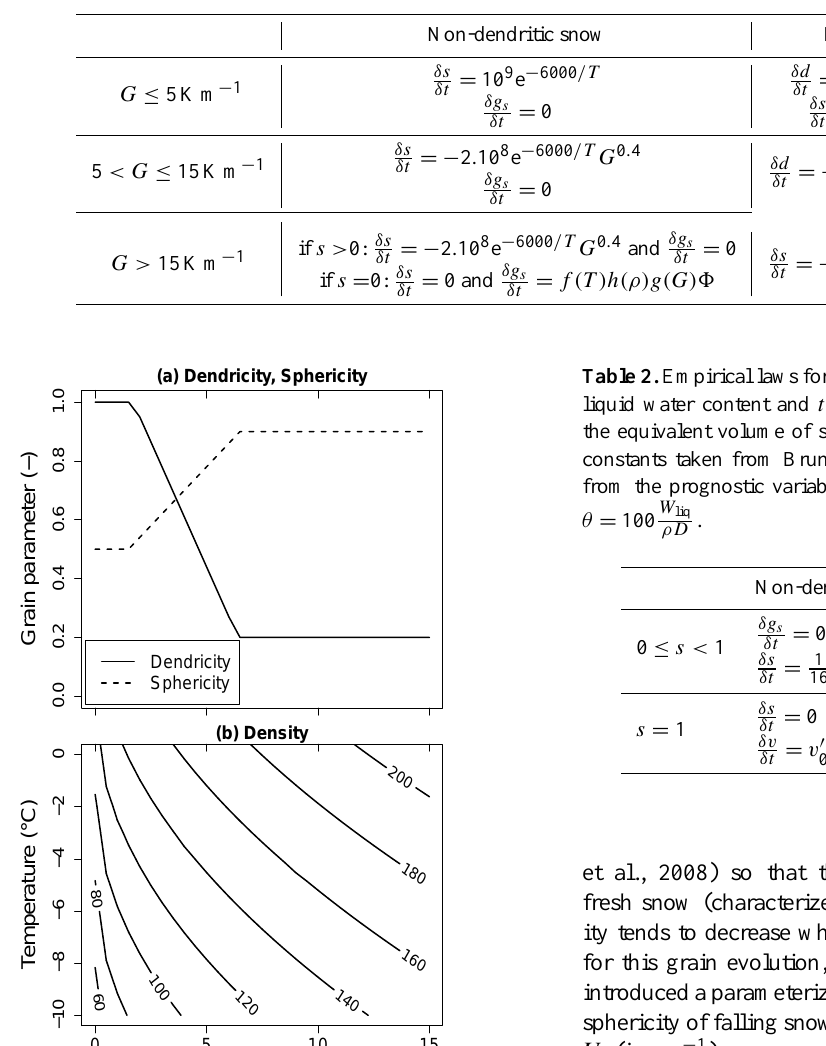
Table 1. Empirical laws for dry snow metamorphism. G is the vertical temperature gradient ( | δT/δz | ) , T the temperature (K) and t is time expressed in days. f , g , h and 8 are empirical functions to predict depth-hoar growth-rate from Marbouty (1980) and are described in Appendix B.